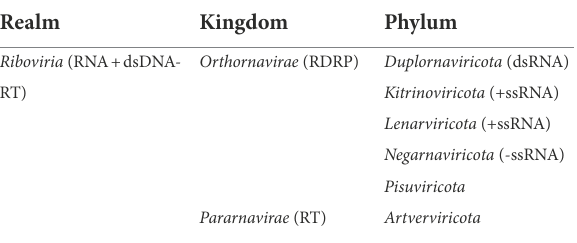
TABLE 1 the 2020 RNA virus ICTV taxonomy. Realm Phylum Riboviria (RNA + dsDNA- Orthornavirae (RDRP) Duplornaviricota RT)